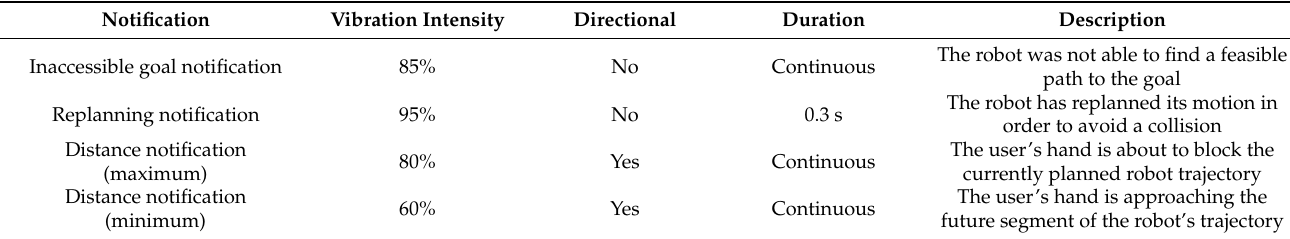
Table 1. Notification vibration intensities.